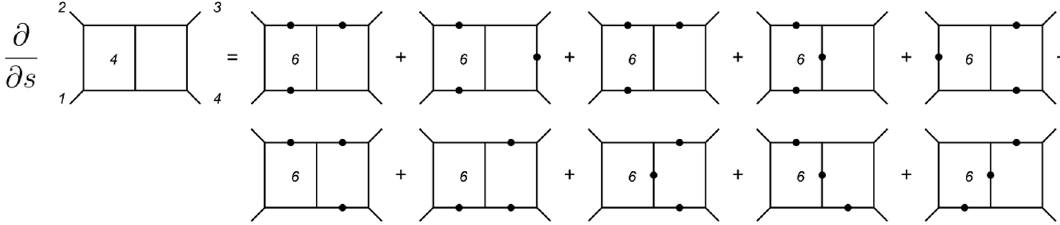
Figure 5 . Additional relation between two loop four point d = 4 and d = 6 double box integrals (their I functions). Note that only the last pair of d = 6 integrals are individually dual conformal. among the triple box and the tennis court